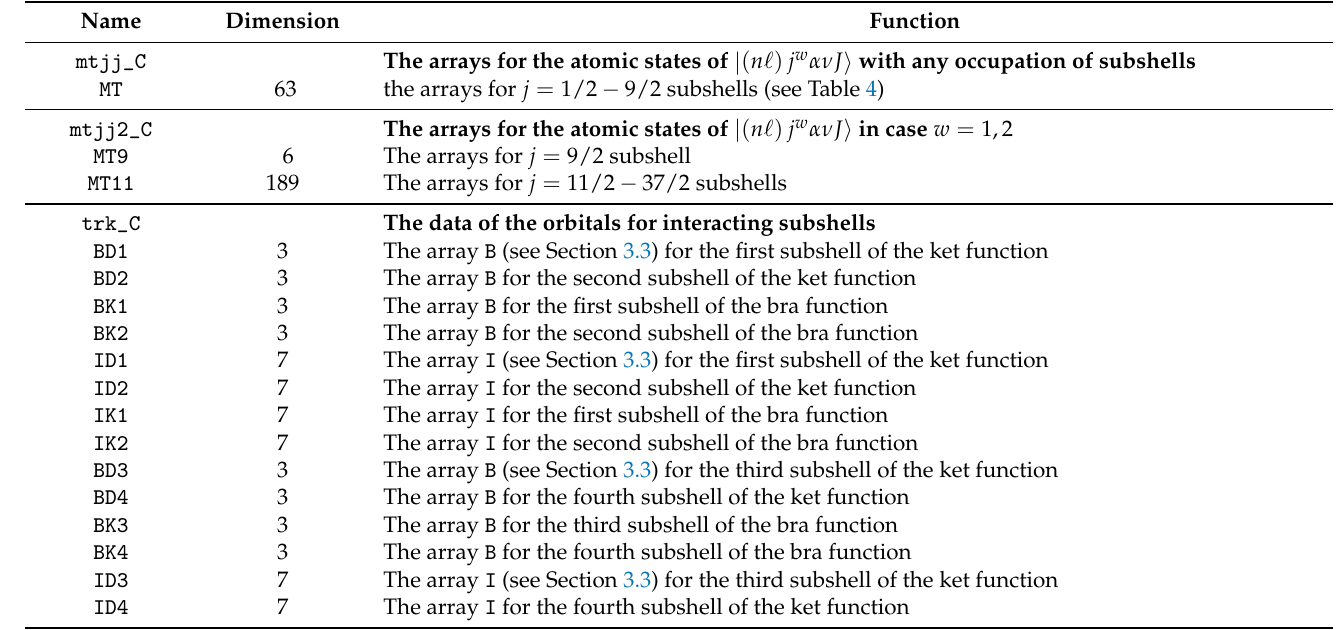
Table 5. Arrays used in this program library for computing pure spin–angular coefficients for one- and two-particle operators in the relativistic atomic